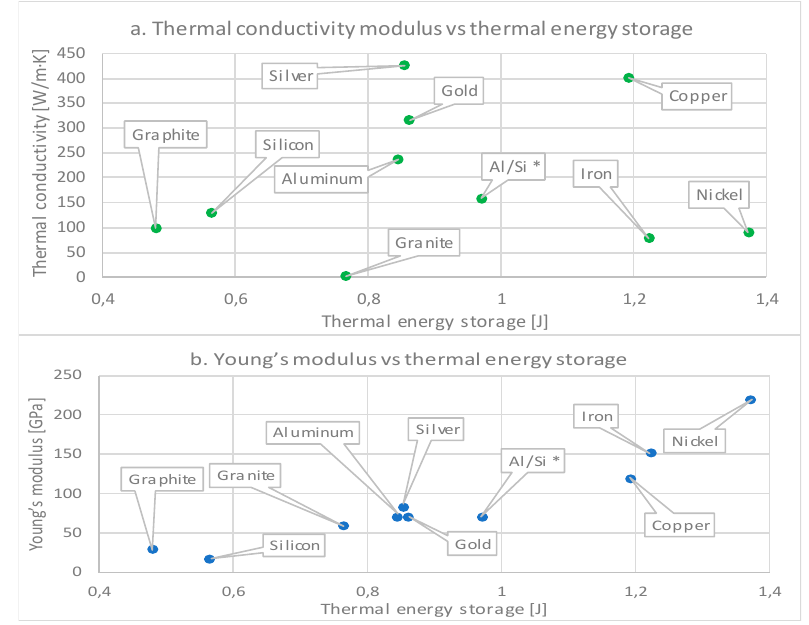
Figure 1. Thermal energy storage respect to: ( a ) Thermal conductivity coefficient and ( b ) Young’s modulus shell materials comparisons .